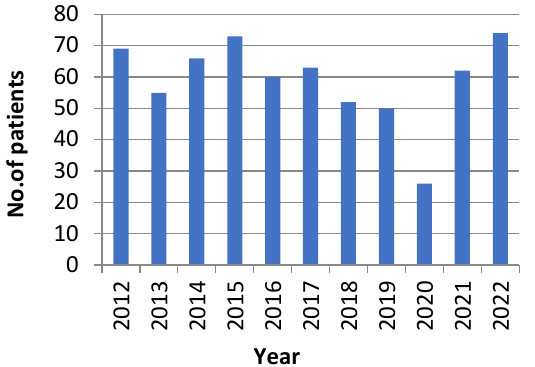
Figure 1. Patients (n = 650) with secondary hyperparathyroidism treated in our clinic in the past 10 years.